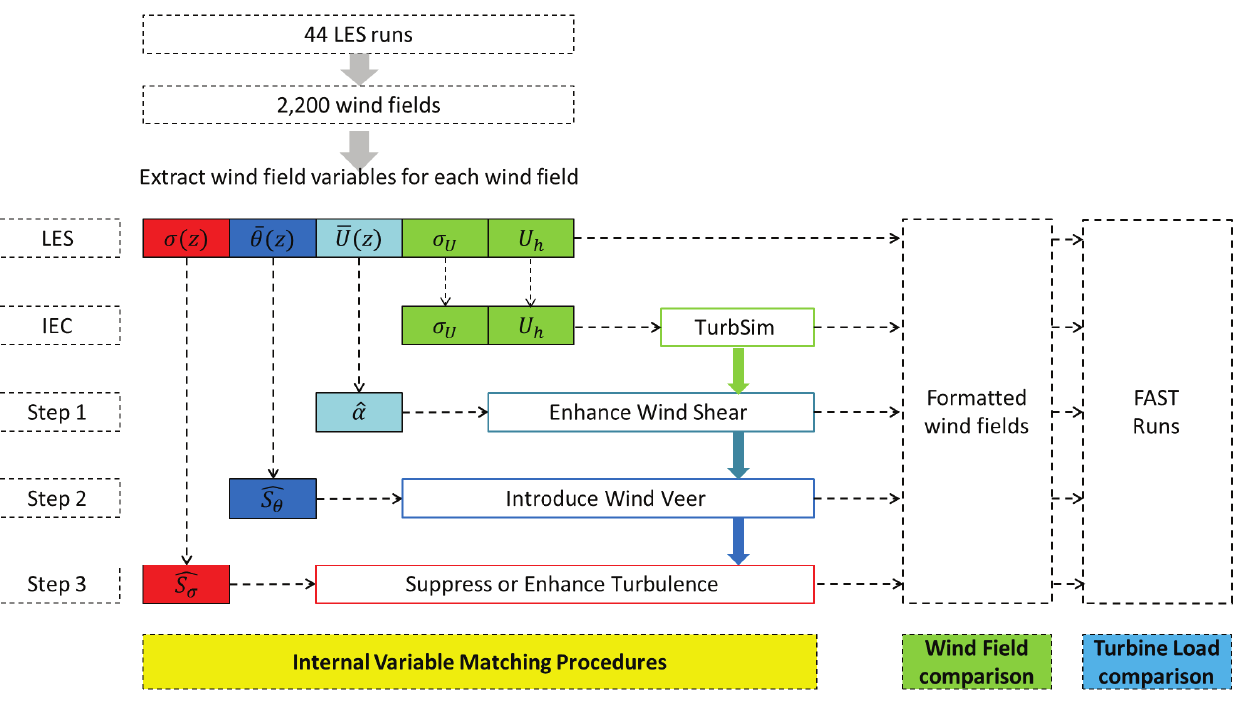
Figure 24. Procedure for isolating SBL-related wind field characteristics and comparing their influences on wind fields and turbine